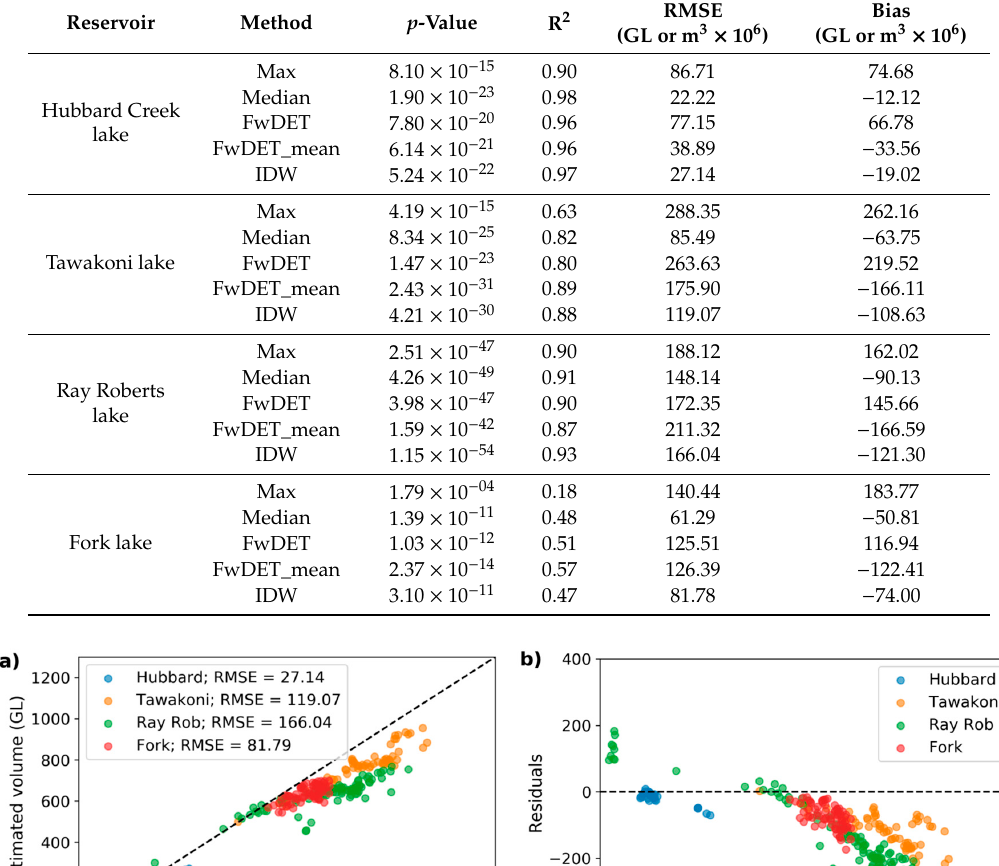
Table 4. Performance of the di ff erent methodologies used to estimate water volumes in Texas reservoirs.